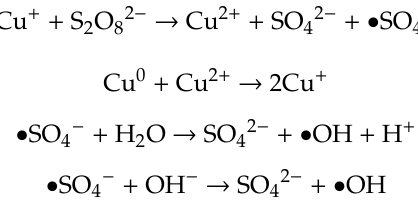
Figure 4. The absorption ( a ) and degradation ( b ) of dye brilliant red (X-3B) with different catalysts.